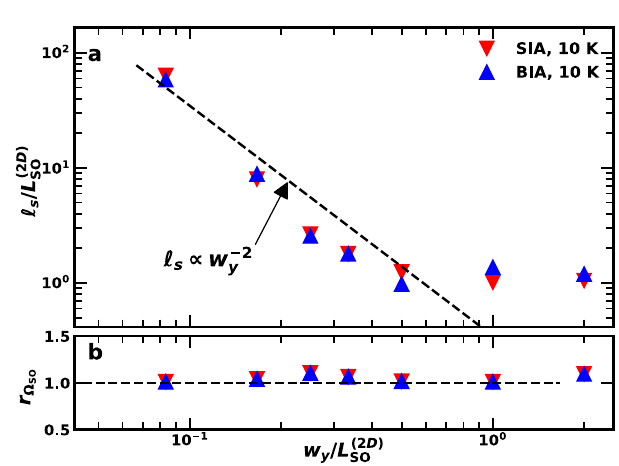
Fig.6|Dimensionalityeffectsonspindephasing.a Spintransportlength, ℓ s ,and = Ω SO ð w y Þ = Ω SO ð w y ! 1Þ as a function of the ( b ) precession frequency ratio r Ω SO channel width, w y , as determined from Monte-Carlo simulations of the acoustic spin transport under SO fi elds with BIA and SIA symmetries. The dashed line in